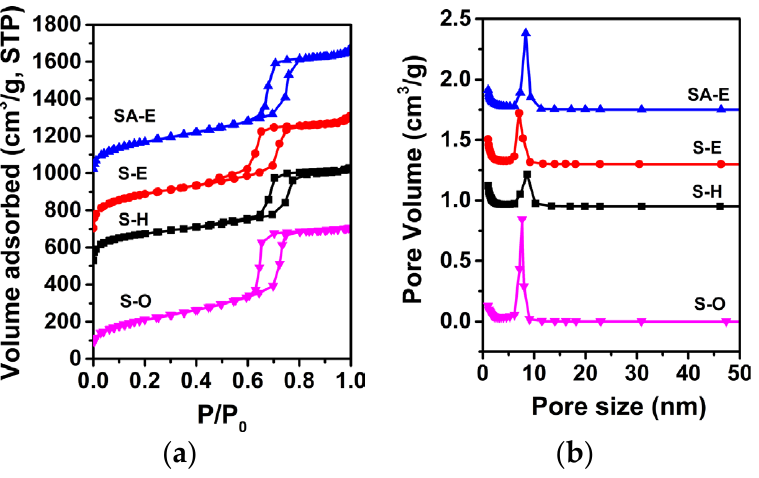
Figure 5. N 2 adsorption – desorption isotherms and the corresponding pore size distribution curves of samples S - O, S - E, S - H, and SA - E. For clarity, in ( a ), the isotherms of S - H, S - E , and SA - E are offset along the Y axis by 440, 610, and 930 cm 3 /g, respectively. In ( b ), the Y axis values are 0.9, 1.3, and 1.7 cm 3 /g higher for Samples S - H, S - E , and SA - E, respectively.